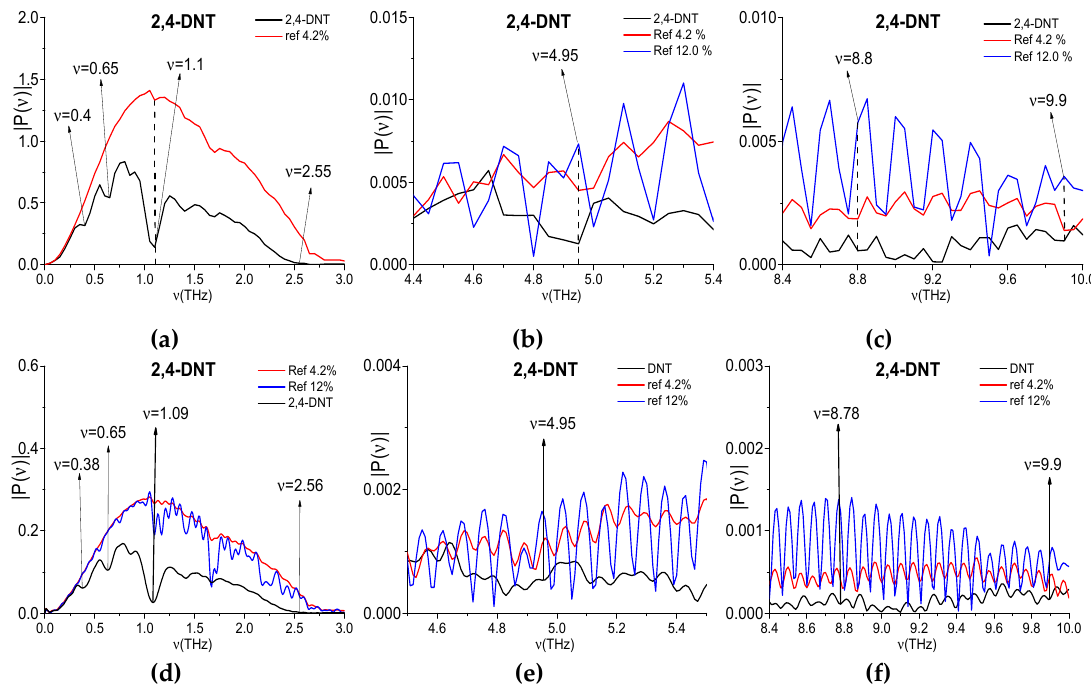
Figure 12. Spectrum of the 2,4-DNT signal measured at 4.2% humidity (black line) and the reference spectra measured at 4.2% humidity (red line) and 12% humidity (blue line) in the frequency ranges ν = [0, 3.0] THz ( a , d ), [4.6, 5.4] THz ( b , e ) and [8.4, 10.0] THz ( c , f ). Spectral resolution is equal to Δν = 0.05 ( a – c ), 0.01 ps ( d – f).